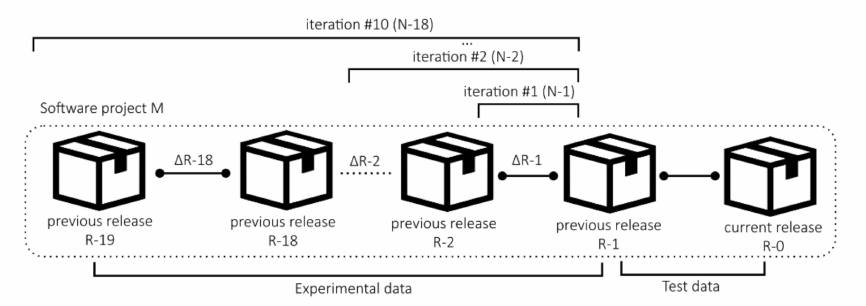
Figure 6. The iterations of the